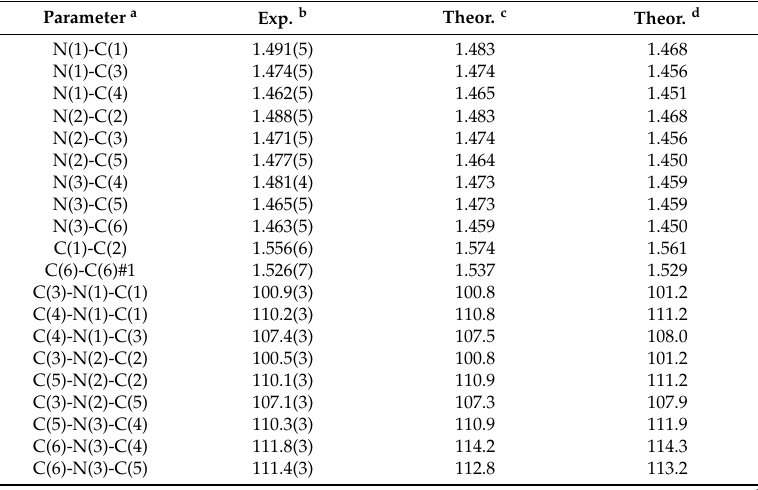
Table 3. Selected bond length (Å) and angles ( ◦ ) for ETABOC dihydrate. Parameter